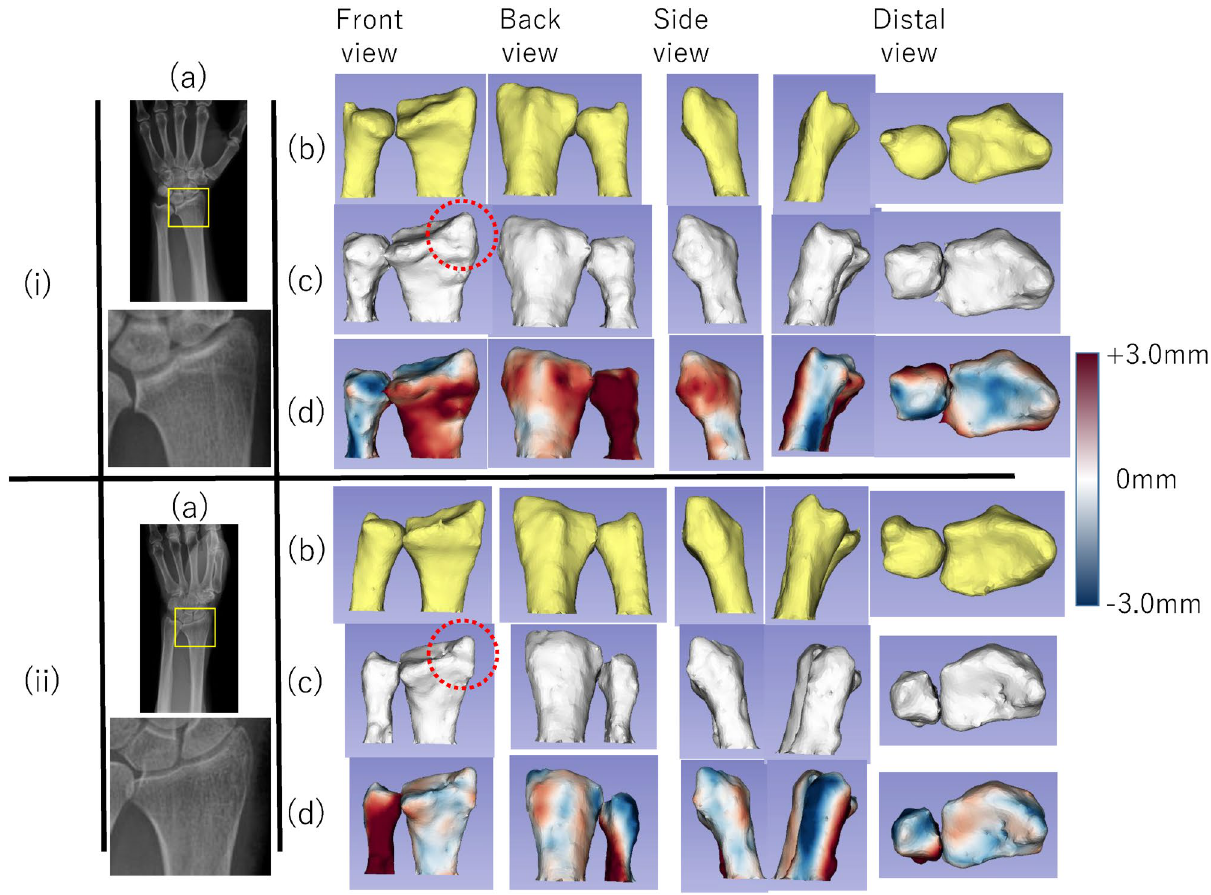
Figure 8. Example of the 2D–3D reconstruction result for actual X-ray images. (i) Average result (ASDs: radius, 0.95 mm; ulna, 1.34 mm). ( a ) actual X-ray image ( b ) ground truth; ( c ) 3D bone model estimated by GAN-DRR; (d) visualization of ASD. ( ii ) Good result (ASDs: radius, 0.49 mm; ulna, 1.50 mm). ( a ) actual X-ray image ( b ) ground truth; ( c ) 3D bone model estimated by GAN-DRR; ( d ) visualization of ASD. Red circle in ( c ) showed that the shape of the radial styloid process was reconstructed in each